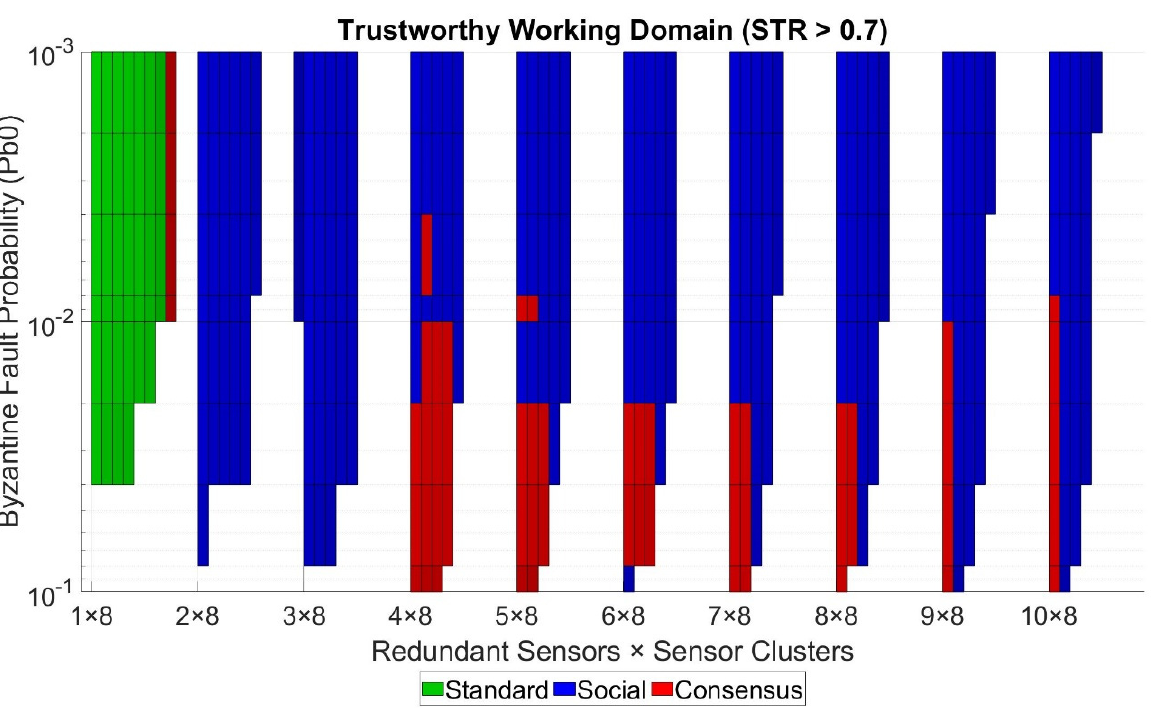
Figure 7. Trustworthiness mesh top view, coloring working domains with STR > 0.7.